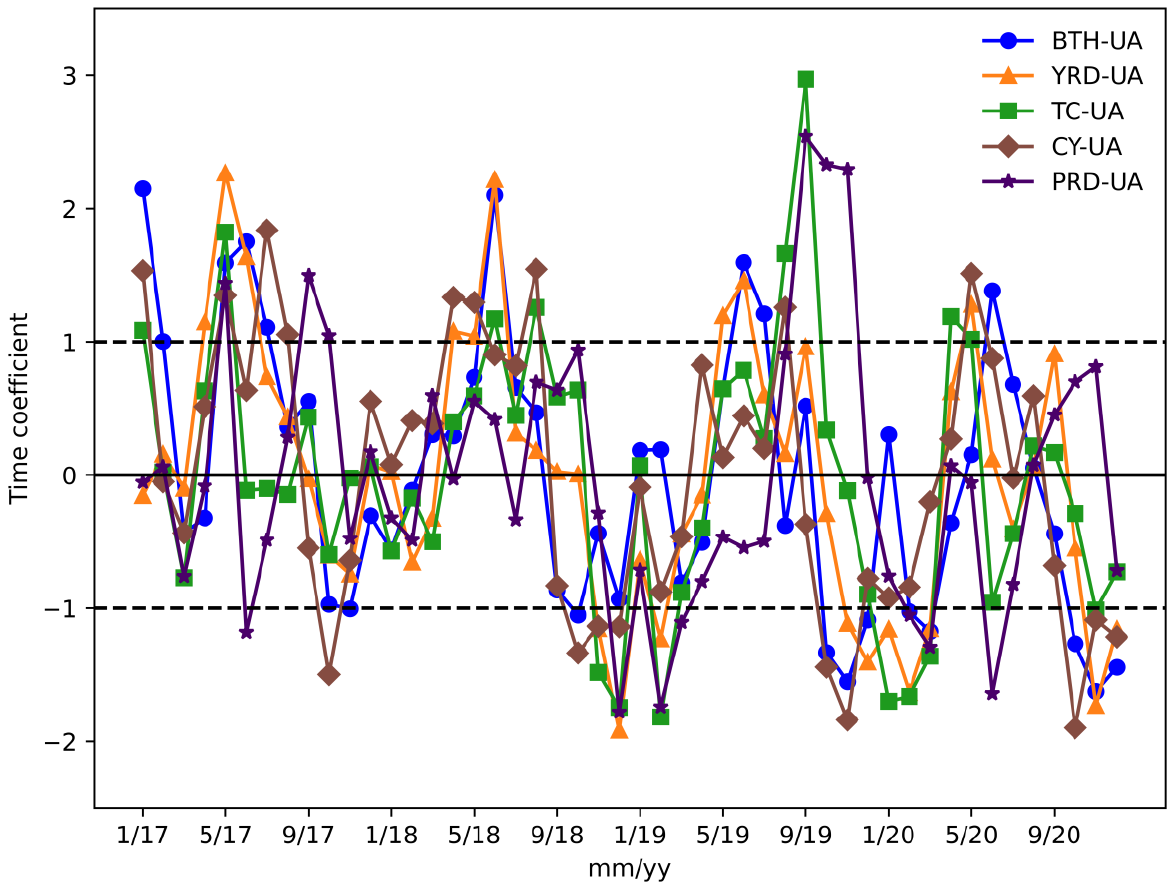
Figure 4. Time coefficients of the monthly average of MDA8 O 3 concentrations in five urban agglomerations during 2017 – 2020.